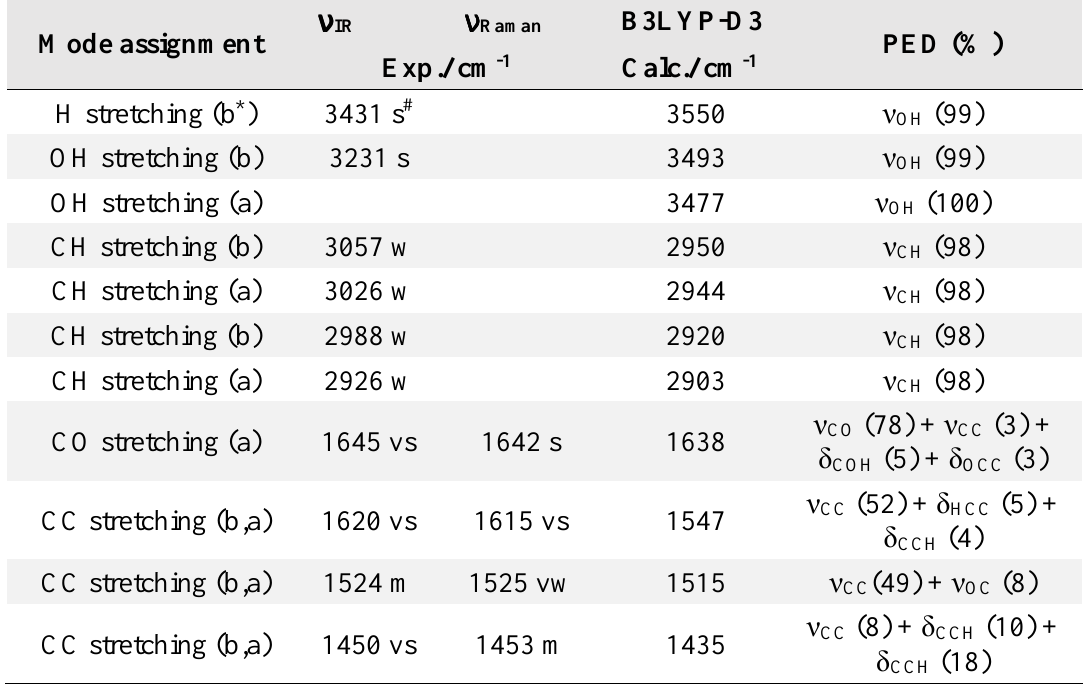
Table 1. Characteristic experimental ( Ś WISŁOCKA , 2013) and calculated wavenumbers ( n ) in the vibrational spectra of caffeic acid along with the assignments and intensities of the normal